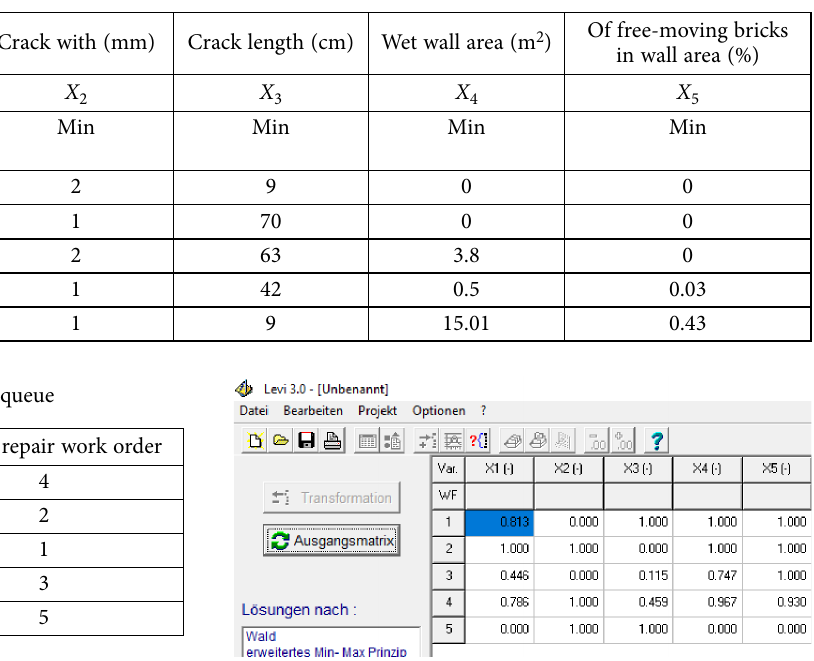
Table 3. Source data matrix